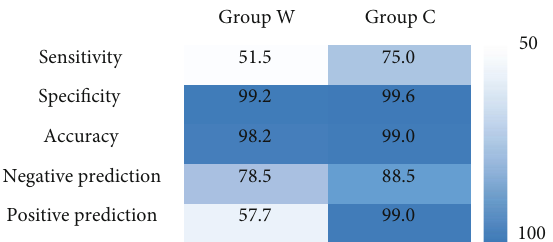
Figure 6: Diagnostic value of echocardiography before and after